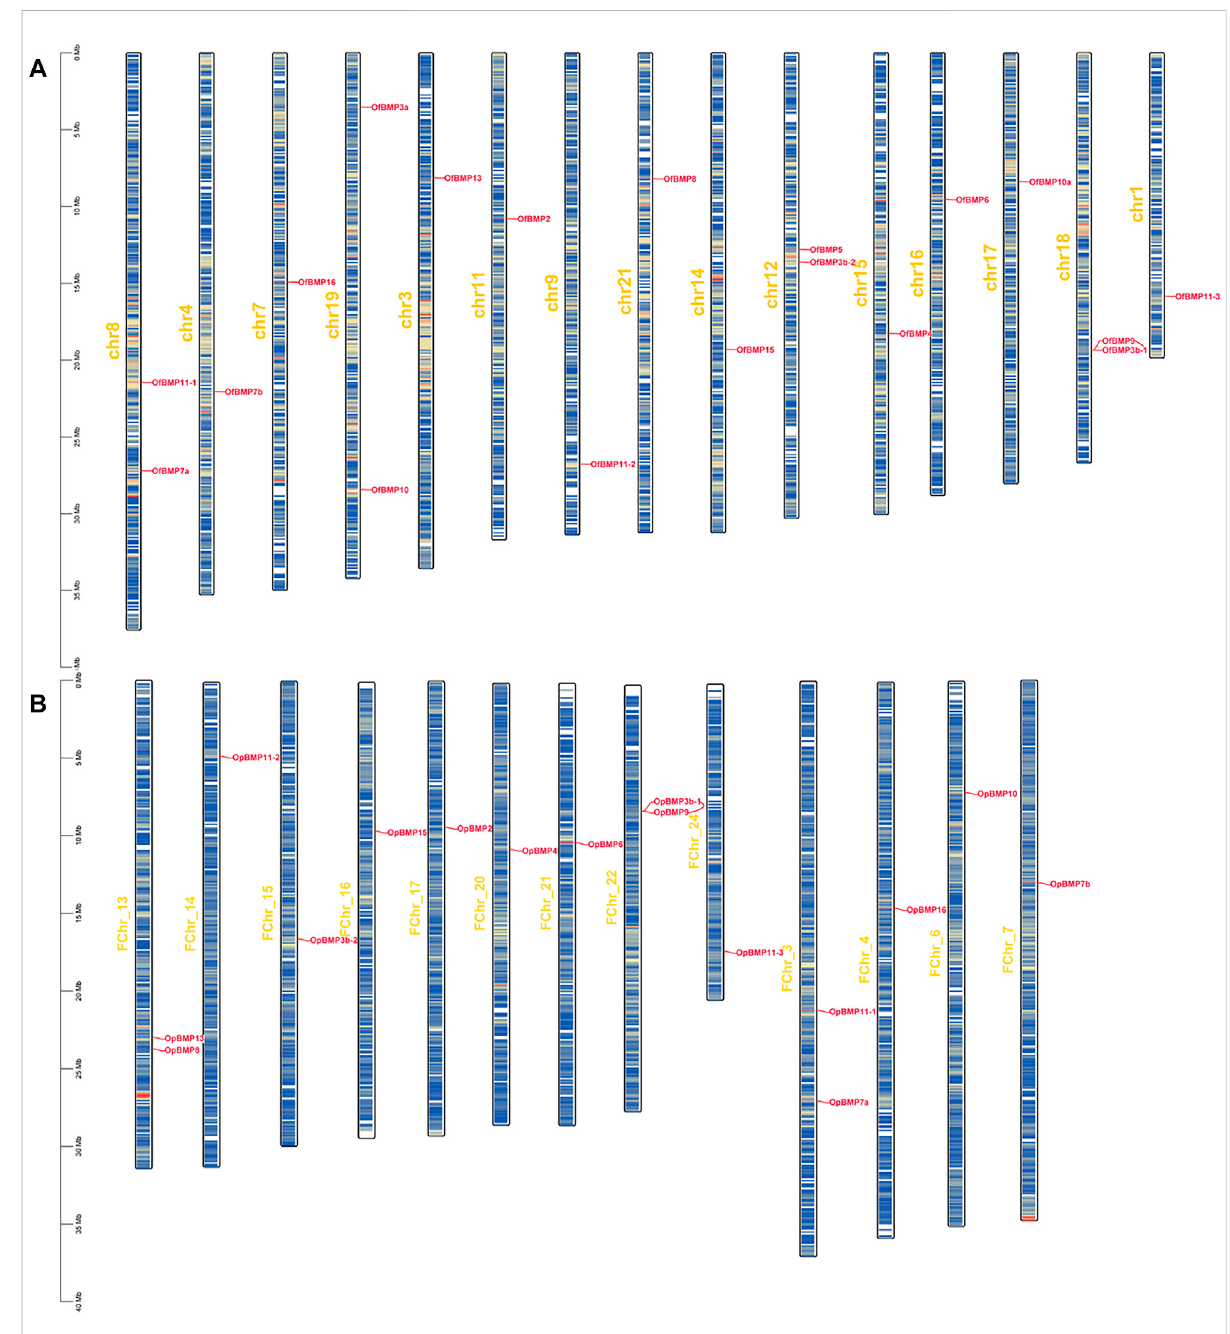
FIGURE 4 ChromosomelocalizationofBMPgenesin O.fasciatus and O.punctatus . (A) Represents O.fasciatus ; (B) represents O.punctatus .Thepre fi x “ F" in the chromosome names in Panel (B) indicates that the reference genomic data are from female O. punctatus